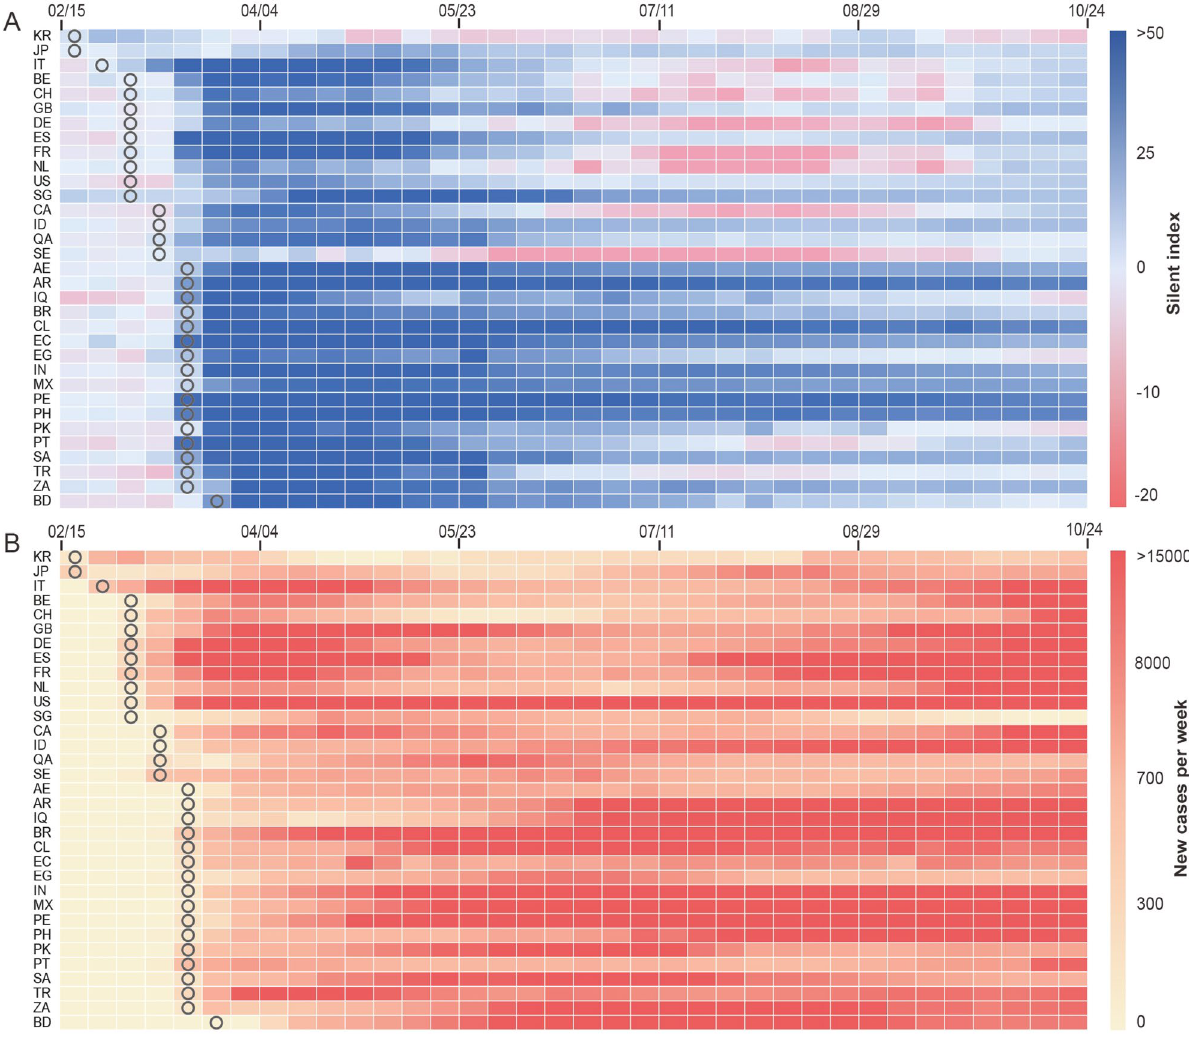
Figure 2. Temporal variations of SI and new COVID-19 cases. The changing of SI ( A ) and newly confirmed weekly cases of COVID-19 ( B ) in 33 selected countries from the baseline day to late October 2020 were visualized with a heatmap. The symbol “ ○ ” indicated the week when the cumulative number of COVID-19 cases reached 100. The 33 countries’ full names can be seen in Table